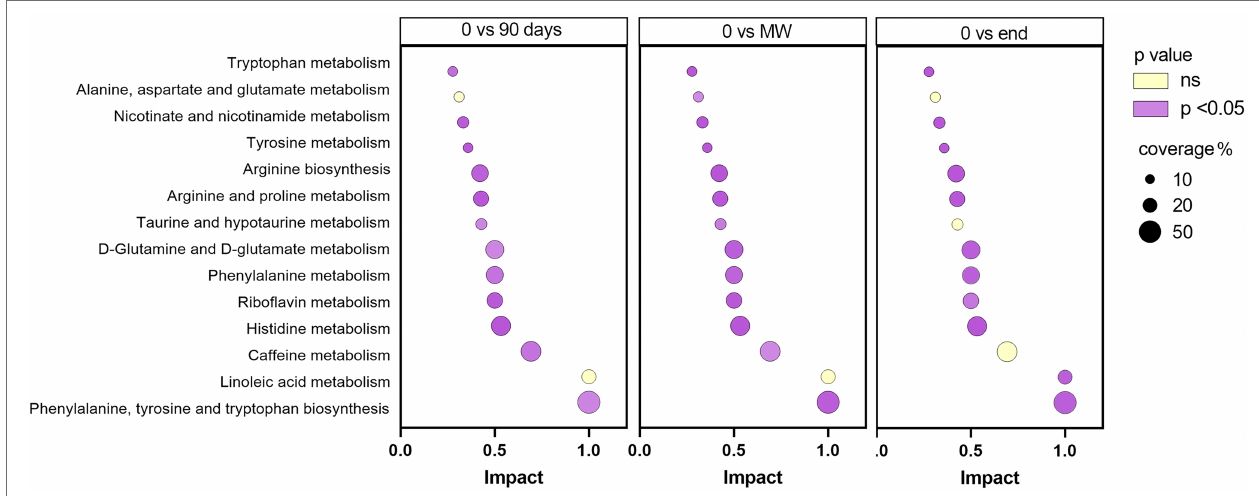
FIGURE 3 | Schematic diagram of the most altered metabolic pathways after 90 days, MW and 9 months in Antarctica with respect to baseline. Values of p were corrected for false discovery rate. Enrichment pathway analysis was performed based on Homo sapiens KEGG pathway networks. In purple, are reported those significantly modulated by performing one-way ANOVA and the Dunnett post-hoc test; in yellow, those not modulated. For each metabolism pathway, the coverage is represented by the size of the circles, while the position on the X-axis indicates the impact in a scale from 0 to